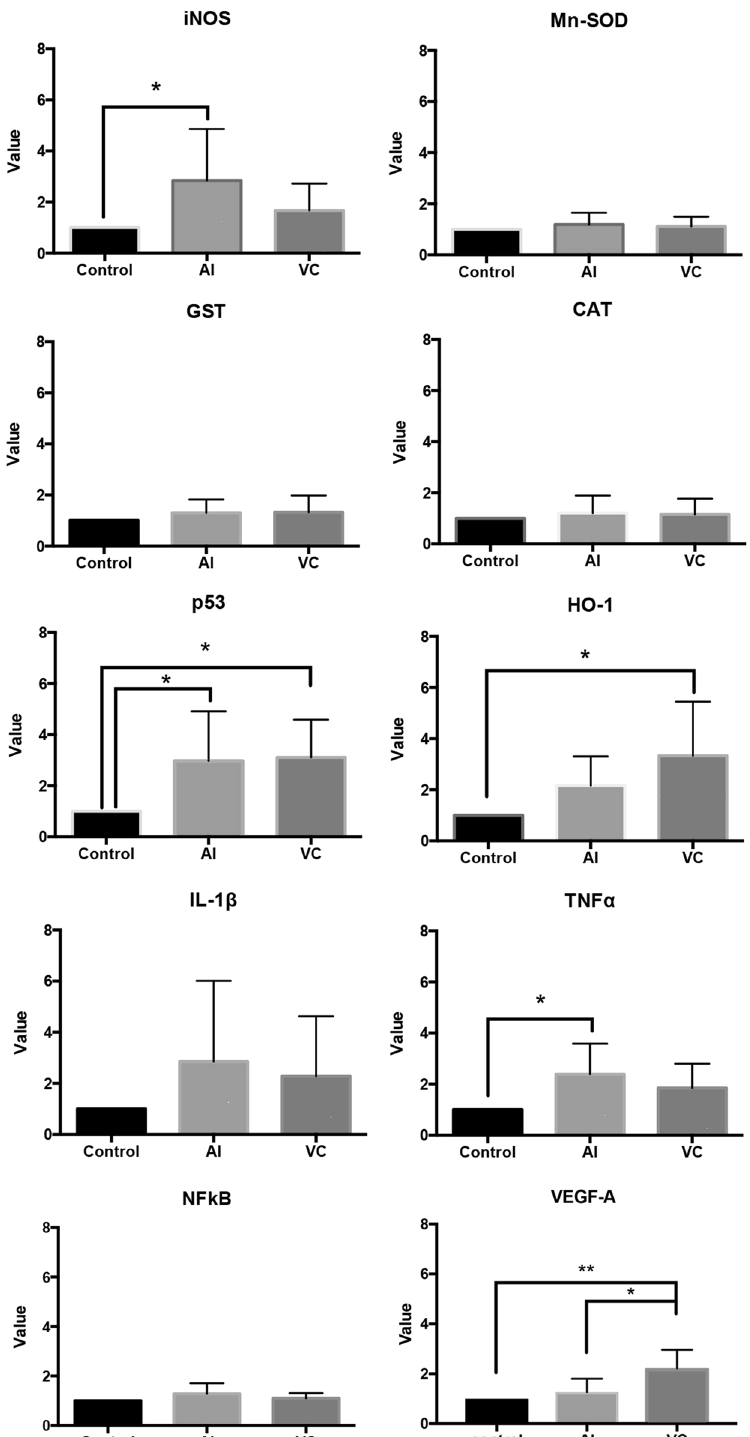
Figure 5. Expression of mRNAs of inducible nitric oxide synthase (iNOS), superoxide dismutase (SOD), glutathione- S -transferase (GST), catalase (CAT), p53, haem oxygenase (HO)-1, interleukin (IL)-1 β , tumor necrosis factor (TNF)- α , nuclear factor kappa-light-chain-enhancer of activated B cells (NF- κ B) and vascular endothelial growth factor (VEGF)-A from rat testes with arterial ischaemia (AI) and venous congestion (VC) at 6 h. Relative intensity was calculated after normalising the expression to that of the control (taken to be 1). Each bar represents the mean ± SD ( n = 6). * P < 0.05. *** P <